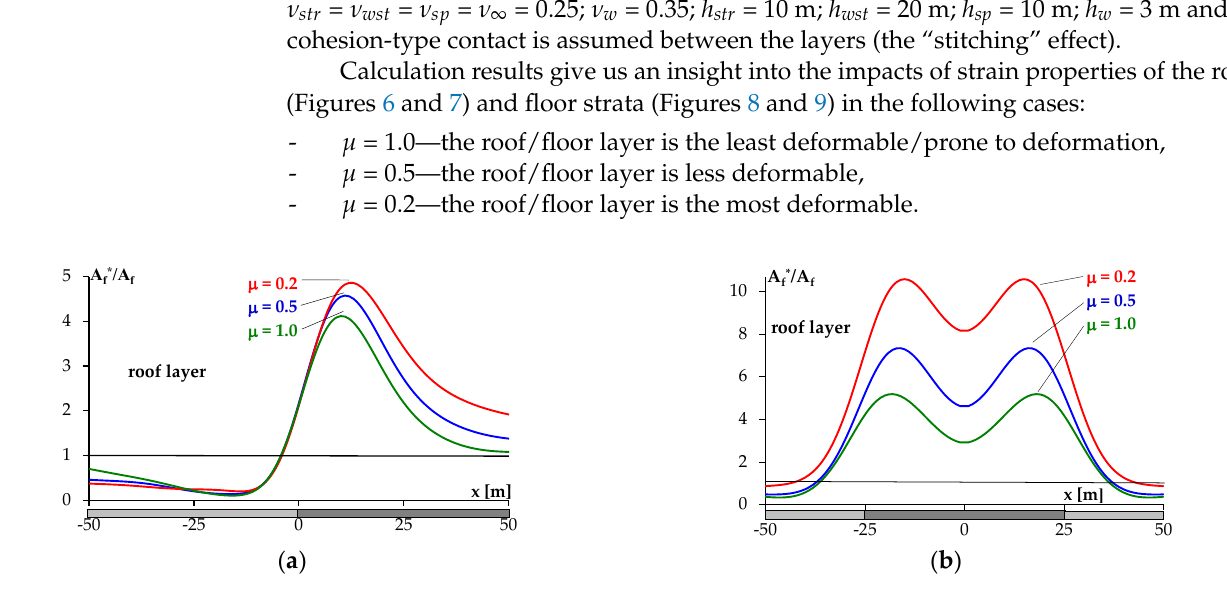
Figure 6. Distribution of the energy concentration coefficient of volumetric strain for different strain properties of the roof layer in the area of: ( a ) the exploitation edge, ( b ) the residual pillar.